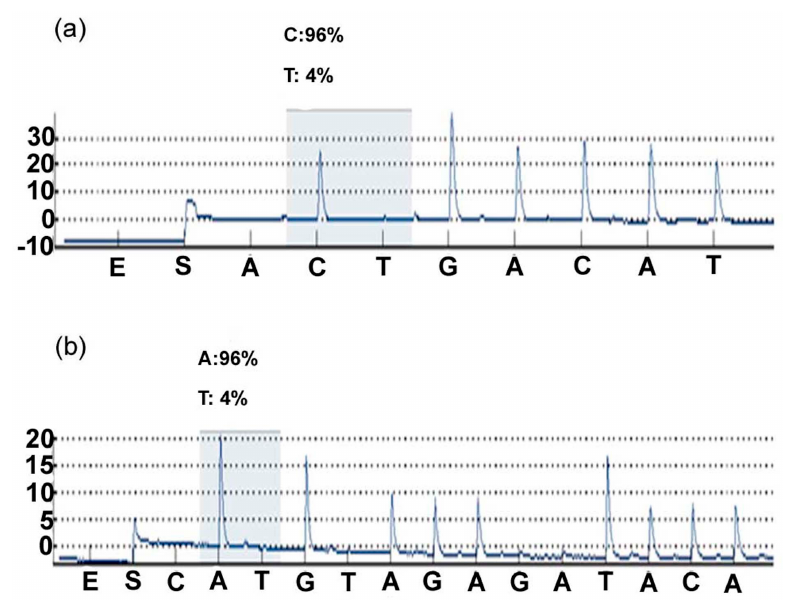
Figure 1. EGFR and FGFR2 mutations were validated by pyrosequencing of cSCC specimens. ( a ) EGFR g. 55249110 G > A ( b ) FGFR2 g. 123274818 T > A. Both ( a , b ) are reverse sequences.